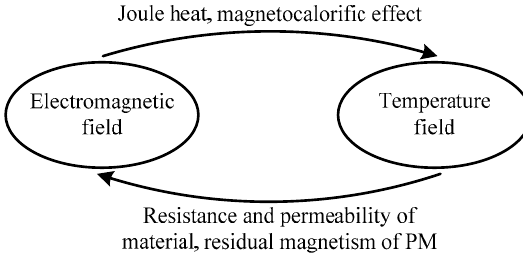
Figure 2. Schematic diagram of coupling relationship.